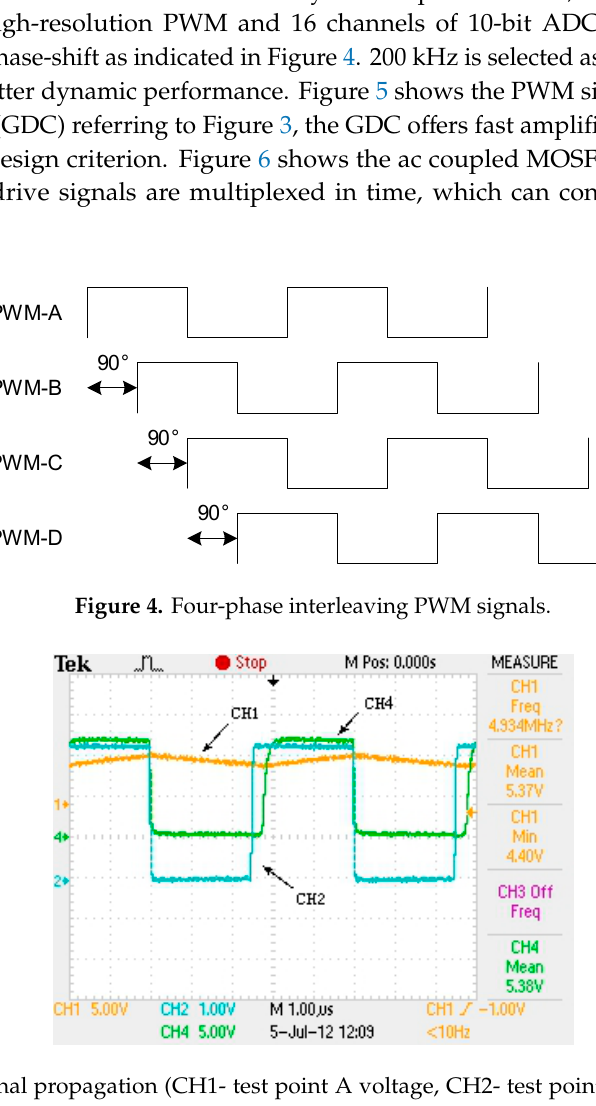
Figure 5. Gate signal propagation (CH1- test point A voltage, CH2- test point B voltage, CH4- test point C voltage).